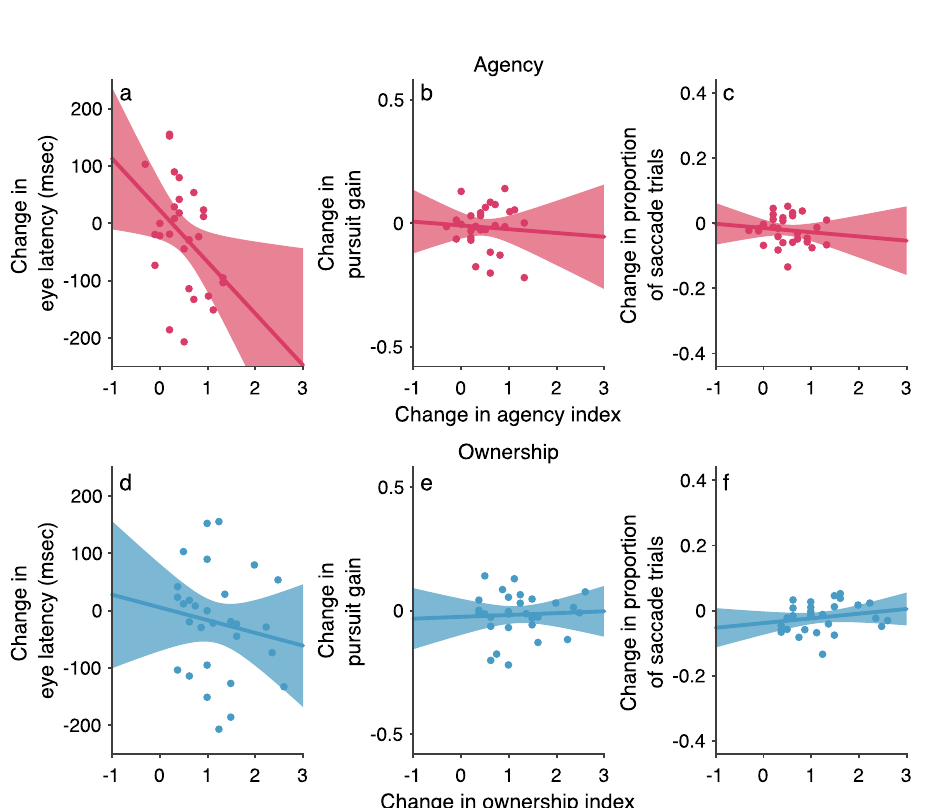
Figure 5. Correlation between body awareness and eye–hand coordination performance in experiment 2 ( n = 29). ( a – c ) Agency. ( d – f ) Ownership. Change in eye–hand coordination performance [i.e., eye latency ( a , d ), pursuit gain ( b , e ), and proportion of saccadic trials ( c , f )] was defined as the change in performance when the sense of agency or the sense of body ownership became stronger in the active-synchronous condition compared with the active-asynchronous